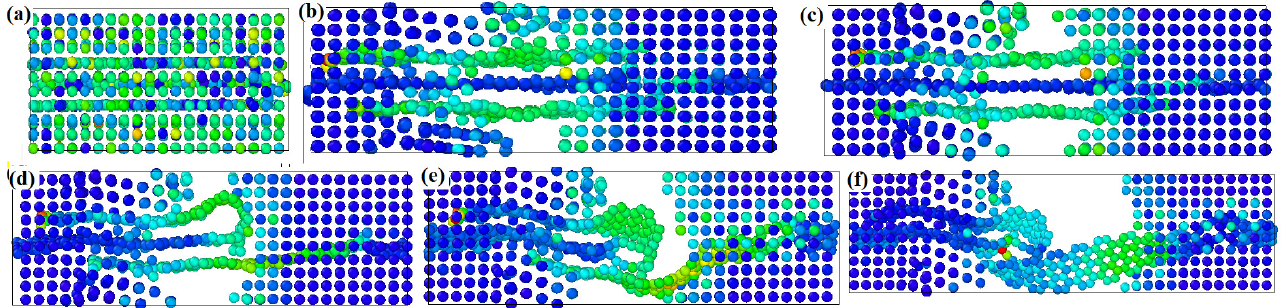
Figure 11. Stress distribution of three-layer graphene/aluminum composite during tensile failure. ( a – f ) represent the process of matrix cracking until material failure during